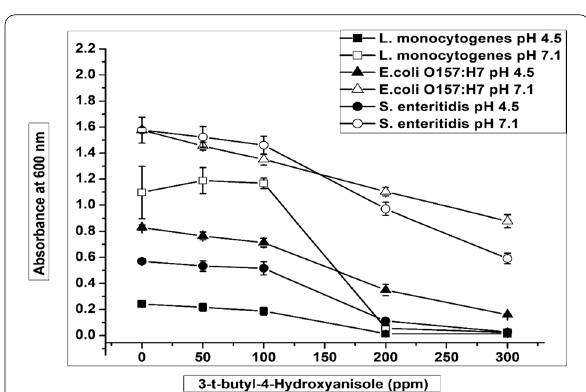
Fig. 6 Influence of different pH values on bactericidal activity of 3- t -butyl-4-Hydroxyanisole against E. coli O157:H7 , S. enteritidis, and L. monocytogenes . 3- t -butyl-4-Hydroxyanisole concentrations (0, 5, 10, 15, 20, and 25) ppm were each added to 10-ml tryptone soya broth tubes and then inoculated (50 μl) of an overnight culture of bacterial suspension (O.D 600 1.818). Tubes were incubated at 37 °C for 24 h. = Negative and positive controls were performed. The optical density of each tube was measured using a spectrophotometer. Data shown as a mean of two independent experiments with standard error ( P <